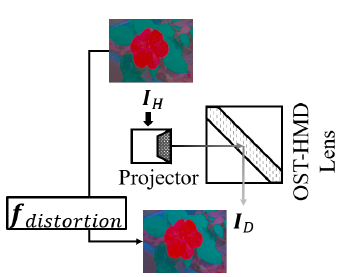
Figure 6. f distortion : Given an input I H to the OST-HMD, what appears on the